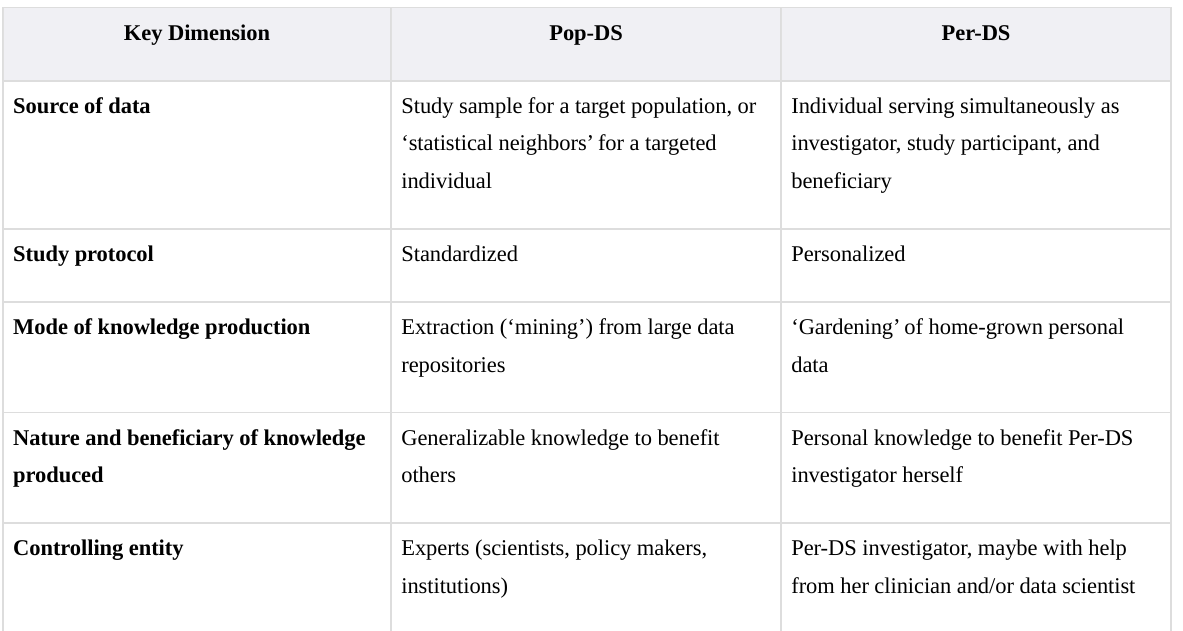
Table 1. Distinguishing features for Per-DS versus